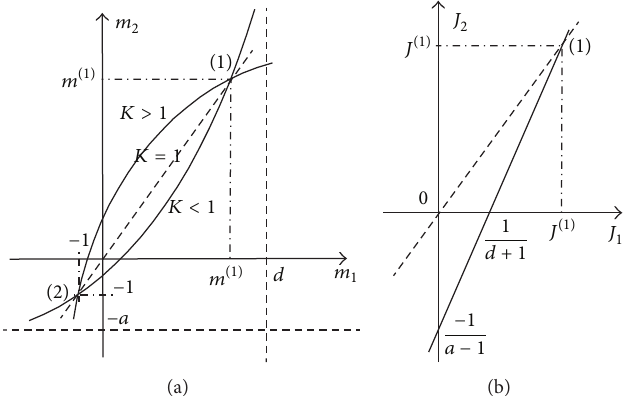
Figure 2: Correlated changes of source loading parameters: (a) is as a family of hyperboles 𝑚 2 (𝑚 1 ) for various values of nonuniformity factor of loading 𝐾 ; (b) is as a straight line 𝐽 2 (𝐽 1 ) .